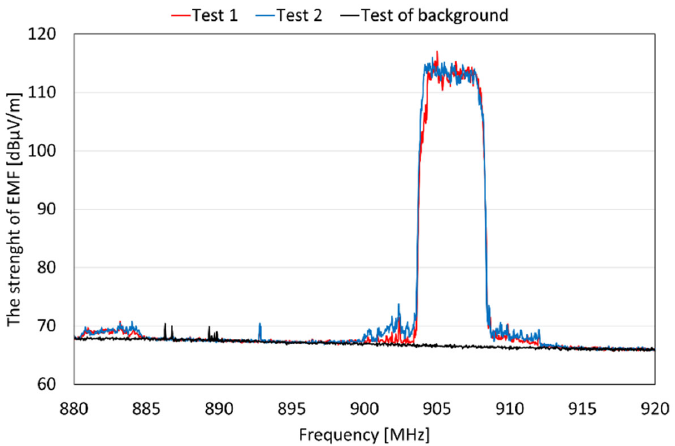
Figure 5. Measurement results of electromagnetic field strength generated from a Samsung phone at a distance of 0 cm.